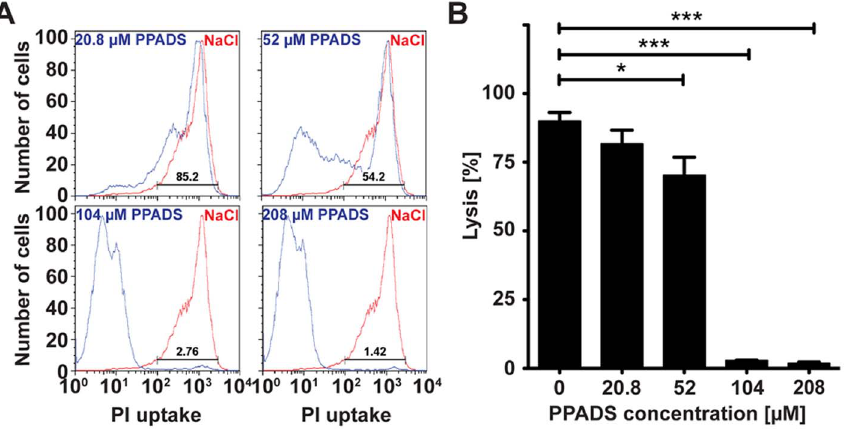
Figure 2. PPADS Inhibits Complement Mediated Cell Lysis . A ) Representative flow cytometry plots indicating number of Hepa1c1c7 cells taking up propidium iodide (PI) when incubated in 1% normal human serum (NHS) and various concentrations of PPADS (blue lines) or 0.9% NaCl (red lines). B ) Mean values 6 SEM of PPADS mediated reduction of NHS mediated cell lysis from 5 independent studies. Significant differences are shown as capped lines between vehicle control (0.9% NaCl, 0 m M PPADS) and the various concentrations of PPADS (*** p , 0.0005, ** p , 0.005, * p , 0.05).